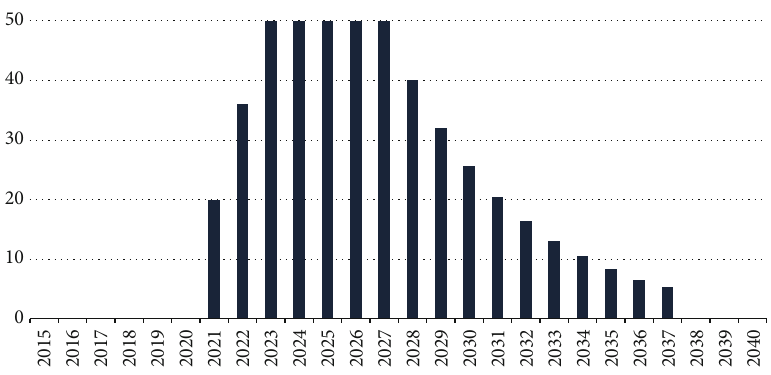
Figure 7: Hess gas production forecast,